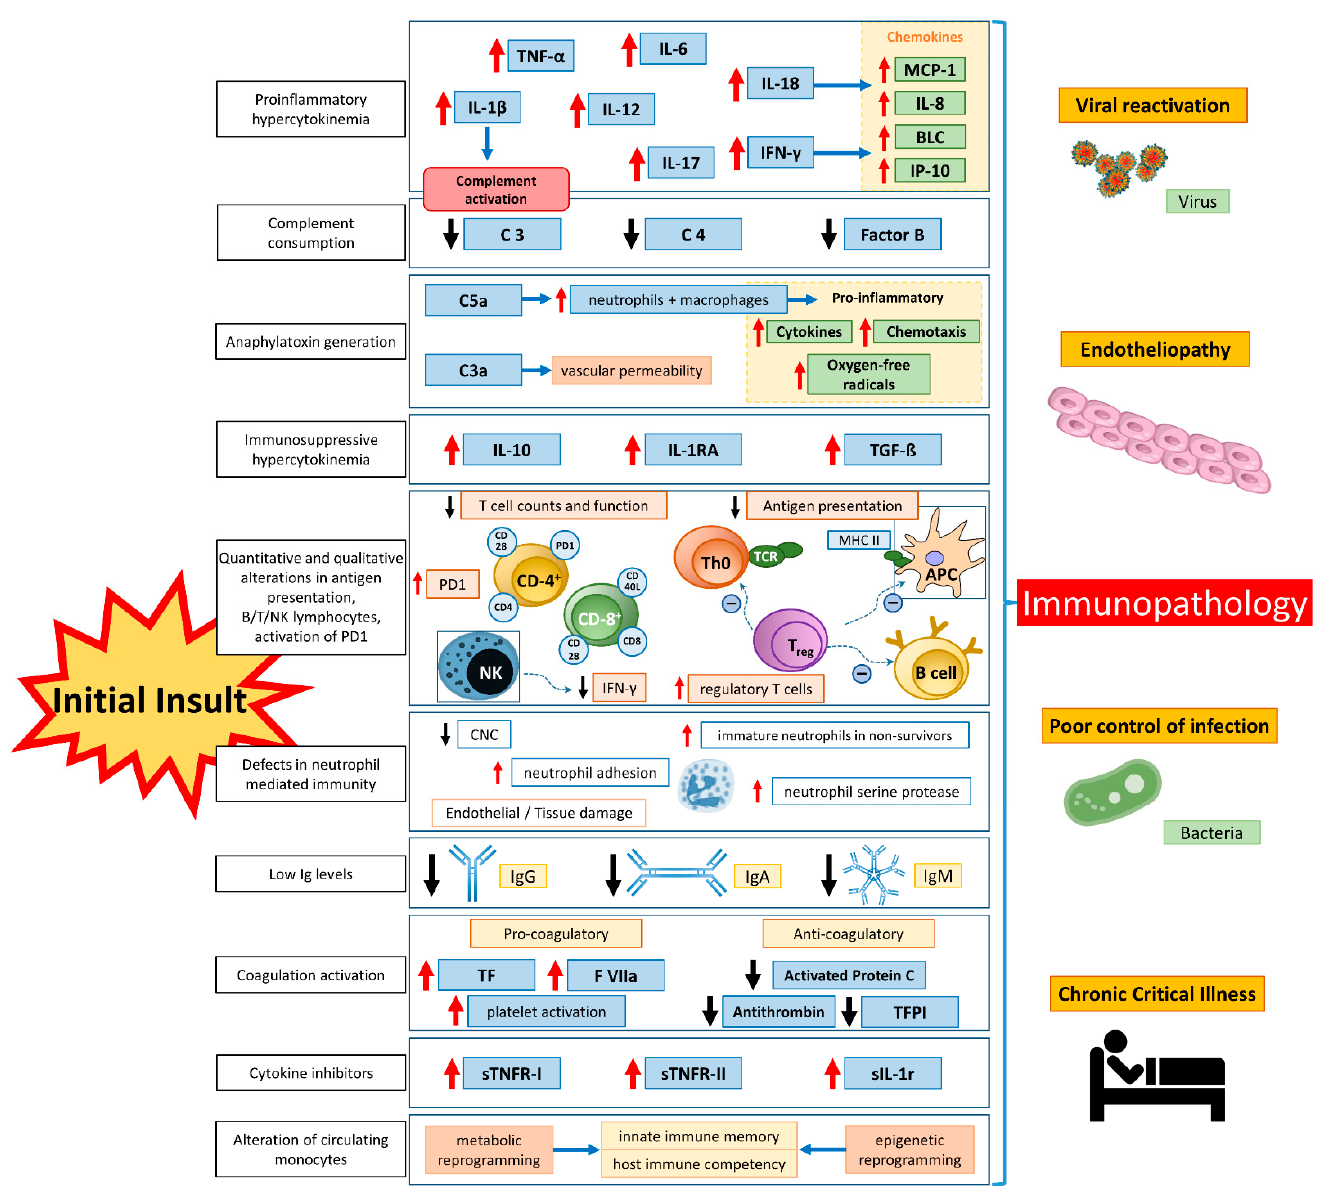
Figure 1. Aspects of immunological dysfunction caused by sepsis with details of the entities involved. APC, antigen-presenting cell; BLC, B-lymphocyte chemoattractant; CD, cluster of differentiation; CNC, critical neutrophil concentration; IFN-y, interferon y; Ig, immunoglobulin; IL, interleukin; IP-10, IFN-gamma-inducible protein 10; MCP-1, monocyte chemoattractant protein-1; MHC II, major histocompatibility complex II; PD1, programmed death protein 1; sIL-1r, soluble interleukin-1 receptor; sTNFR, soluble tumor necrosis factor receptor; TCR, T-cell receptor; TF, tissue factor; TFPI, tissue factor pathway inhibitor; TGF- β , transforming growth factor β . Adapted from Bermejo-Martin JF with permission [151] .